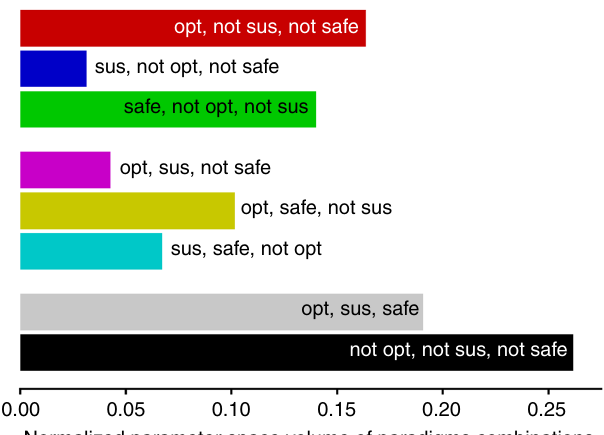
Fig. 4 Ratios of parameter space volumes for all eight paradigms combination. All parameters ( δ , ρ , γ , r l / r h , r min / r h ) were chosen linearly between 0 and 1 for both the risky and the cautious policy. As a direct consequence of our de fi nitions of the safe operating space paradigm and the cautious and risky policy, all paradigm combinations which are safe correspond to the use of the cautious policy, in all others the risky policy was applied. A random decision making agent within a random tipping element will most likely end up with a policy that is neither optimal, neither sustainable nor safe, followed by the parameter sweet spot regime where the policy is simultaneously optimal, sustainable and safe. Interestingly, the third likeliest option is a parameter regime which is optimal, but